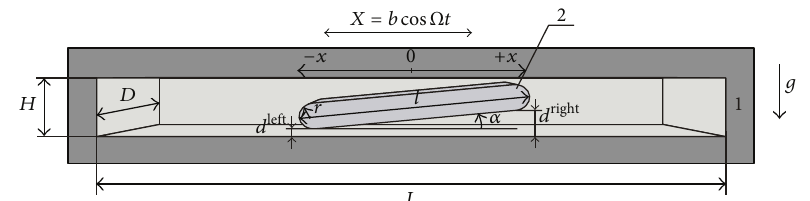
Figure 1: The container with a flat body placed in it.